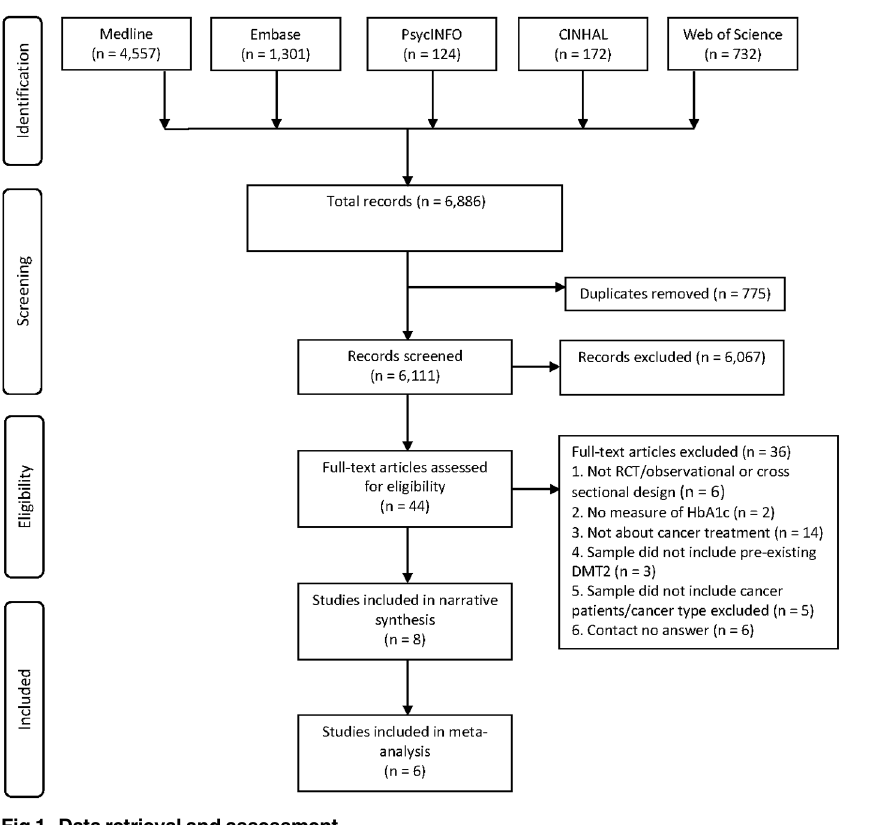
Fig 1. Data retrieval and